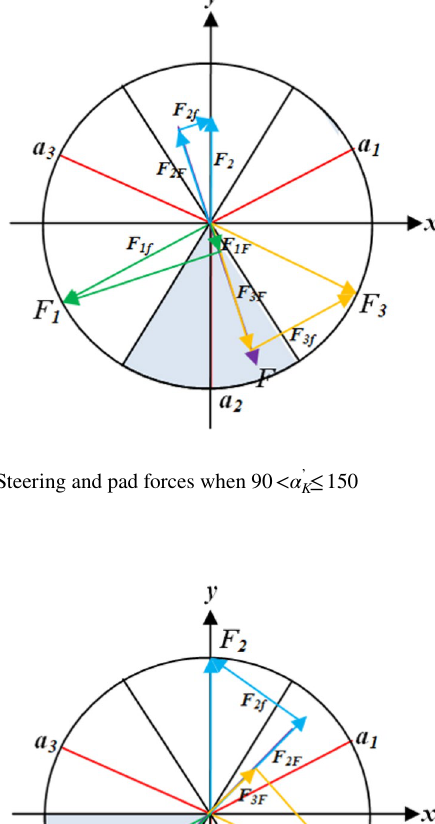
Fig. 11 Steering and pad forces when 30 < α